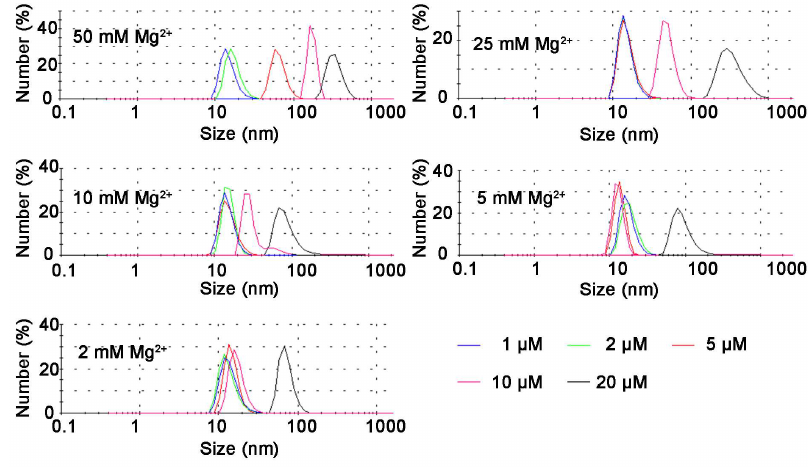
Figure 3. The hydrate sizes of Td (1, 2, 5, 10, 20 μM) prepared in different Mg 2+ concentrations, analyzed by